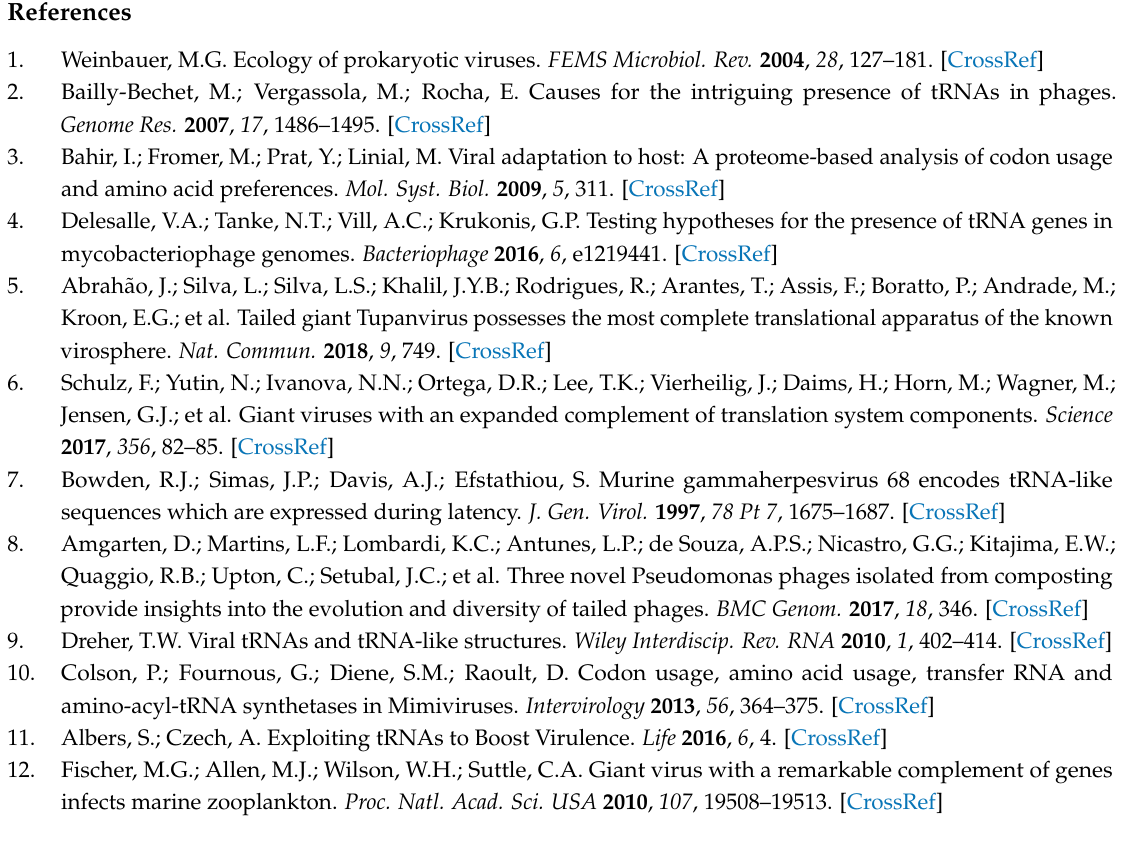
Figure S1: tRNA isotype organization, Figure S2: Maximum likelihood tree based on concatenated tRNA gene nucleotide sequences from tRNA gene clusters, Figure S3: Maximum likelihood tree based on Major Capsid Protein (MCP) amino acid sequences, Figure S4: Codon patterns of the tRNA gene clusters, Figure S5: Bipartite network of gene content associated to the tRNA gene clusters, Table S1: Number of genomes and corresponding viral families identified in the data set, Table S2: List of the predicted tRNA genes in the classified virus genomes, Table S3: Features of viral genomes harboring tRNA gene clusters, Table S4: Number of matching codons, Table S5: CDS associated with tRNA gene clusters shared among the phages, Table S6: List of tRNA gene sequences presenting ≥ 90%